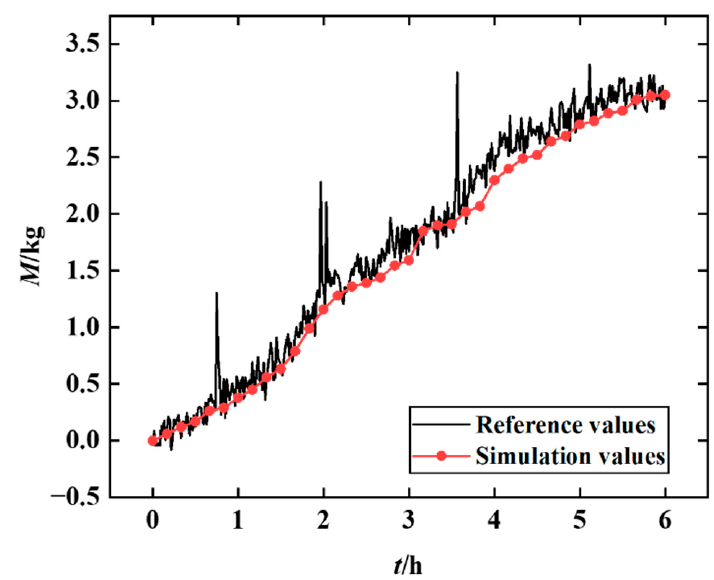
Figure 19. The measured time-varying icing weights of test and simulations. The test results show that the numerical simulation results of the parameters measured by the cylindrical array are close to the measured values when the icing test is carried out in field natural conditions. At 8:00 p.m., the icing weight of the control insulator and that of the numerical simulation were 3.01 kg and 3.05 kg, respectively, with a relative error of 1.3%. Without taking into account interference, the maximum error occurred at about 18:20, while the icing weight of the control insulator was 2.69 kg. Compared with the simulation results, the relative error was 8.0%. The average error of the whole period is 6.8%, which shows that the calculation method of icing parameters proposed in this paper has certain accuracy and engineering